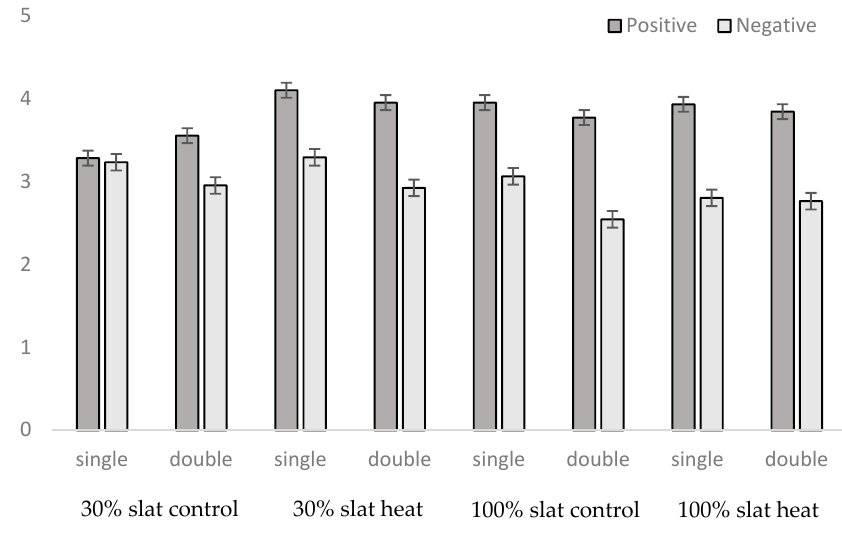
Figure 8. Mean ± SE of number of positive social interactions and negative social interactions per observational period of five minutes depending of the environmental temperature (control vs. heat), type of floor (30% slat 70% concrete vs. 100% slat), and number of feeders (one: single; two: double).